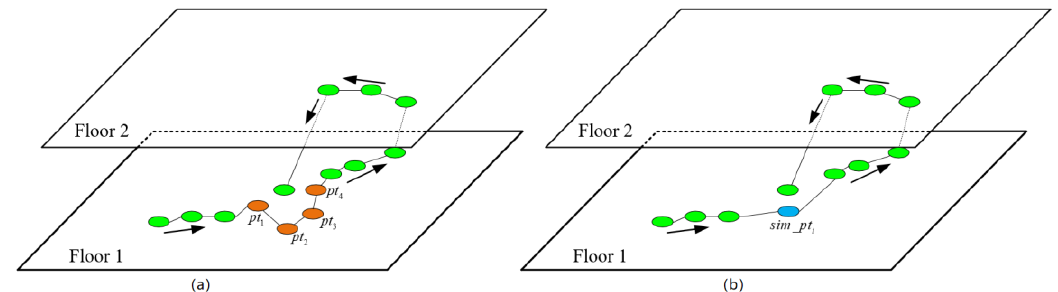
Figure 3. Simplified process of the Indoor-STAGNES algorithm. simplified trajectory of a